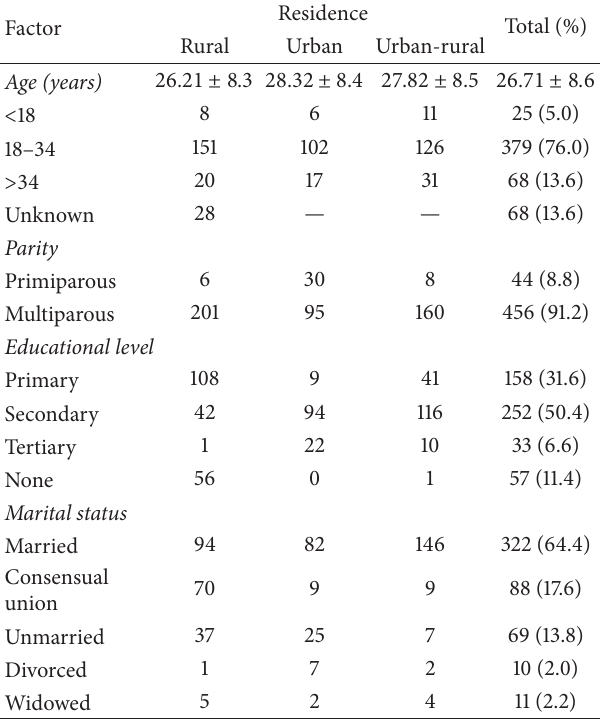
Table 1: Sociodemographic characteristics of participants ( 𝑛 = 500